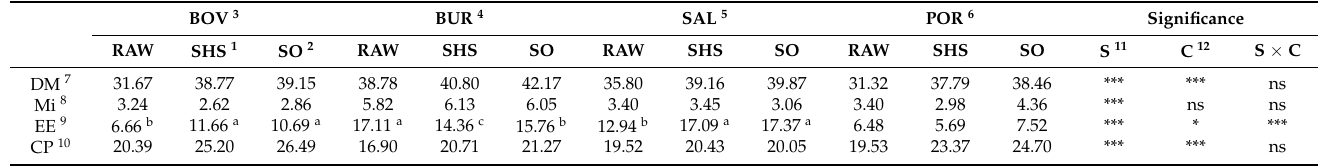
Table 2. Proximate composition of different matrices (g/100 g of